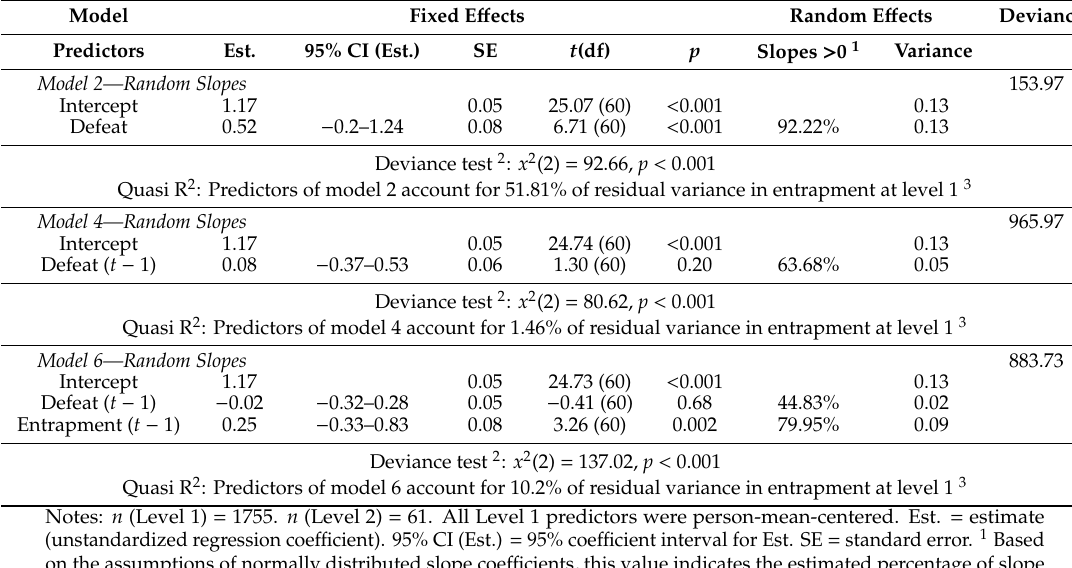
Table 2. Parameter estimates for multilevel models with random